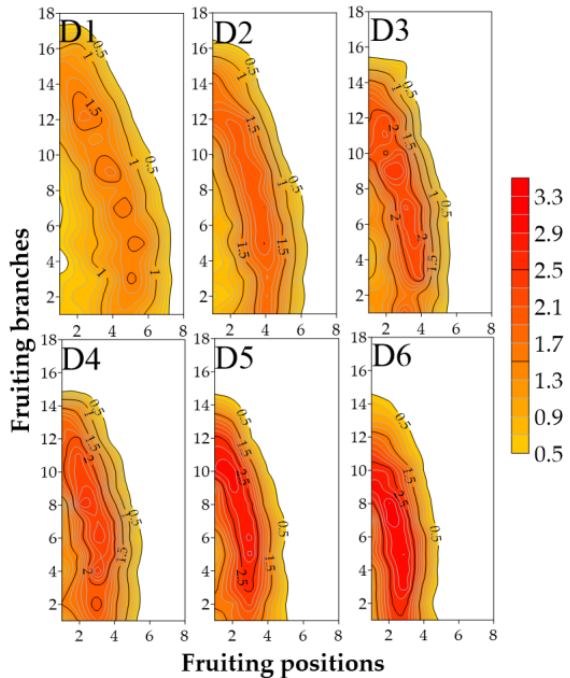
Figure 9. Spatial distribution of the boll shedding rate of per plant at different densities in 2019 and 2020.